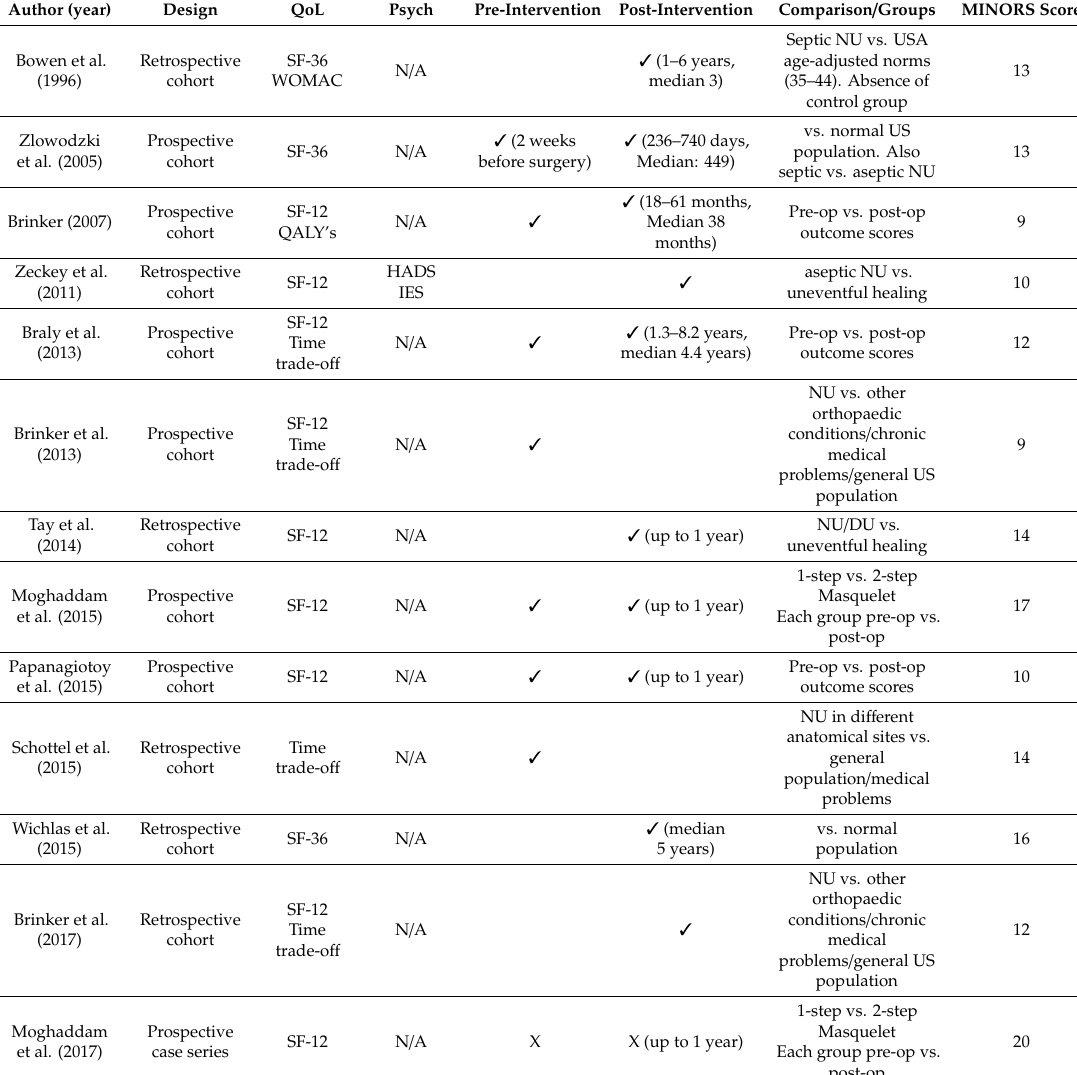
Table 2. Study design, outcome measures, relevant groups and